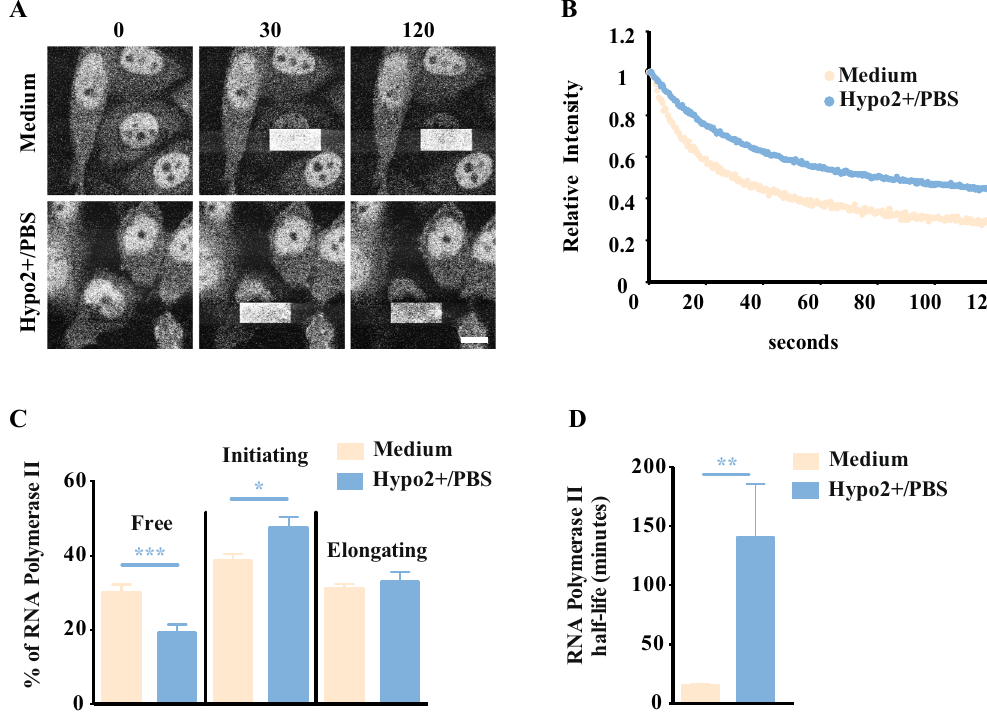
Figure 3. Impact of different osmotic modulations in RNA polymerase II dynamics. ( A ) Fluorescence loss in photobleaching (FLIP) was performed in the LSM 710 (Carl Zeiss) confocal microscope with the stage heated at 39 °C with the CHO RNA Pol II-EGFP cell line. A rectangle of half of each nucleus was selected where 100% laser power was applied, in order to bleach all the fluorescent molecules in these rectangles. This operation was repeated approximately every 5 seconds for a period of 900 seconds originating the decay of fluorescence in the unbleached half. ( B ) Representative decay curves of 2 single cells. The EGFP intensity values in the unbleached area were evaluated with ImageJ and fitted to three populations with an exponential decay = × − × + × × + ∗ ( ) ; R 2 > 0.99:: one free form, one bound to DNA but not fully engaged, and another fully engaged in transcription (see model in Fig. S5 for further details) ( C ) Percentage of different RNA polymerase II forms of the transcription cycle. Data derived from the FLIP analysis allows to estimate the dissociation constants and the percentage of the different populations from decay curves like the ones in B. ( D ) RNA polymerase II half-life data derived from the FLIP analyses showing the impact of hyposmolarity on the speed of transcription. Higher half-life of RNA pol II is indicative of a slower transcription activity. The different osmotic modulation protocols are described in the legend of each graph. The variations presented are the mean value ± SEM (n ≥ 3) and the changes are statistically significant at the time points highlighted in the graphs ( * p value < 0.05; ** p value < 0.01; *** p value <